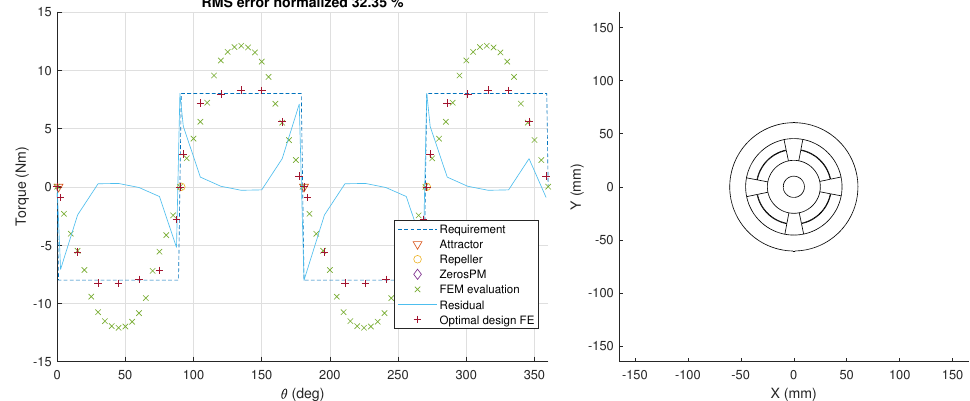
Figure 5. Free shape approach using polynomial formulation, optimization results for rectangular ref- erence torque. Left —FEM torque characteristic calculation, right —initial magnetic spring